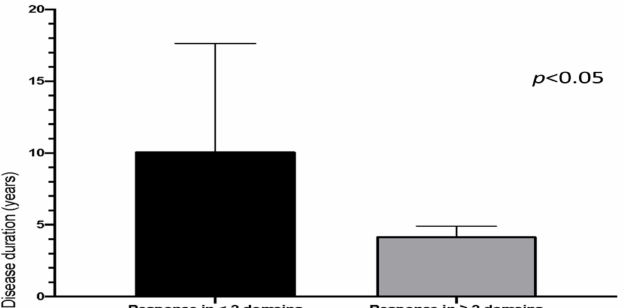
Figure 2. Response to intensified B-depletion therapy (IBCDT) related to systemic sclerosis (SSc) disease duration. Patients are divided in two groups according to the overall response to IBCDT in at least 2 SSc-domains (Modified Rodnan Skin Score, high resolution computed tomography lung, pulmonary function tests, N-terminal-pro-brain natriuretic peptide). Mean disease duration is significantly shorter in those patients who experienced a response to IBCDT in two or more SSc- domains (mean disease duration 4.2 years vs. 10.125 years). Y axis: Years, years of diseases duration (from diagnosis). Results are presented as mean ± standard error of the mean